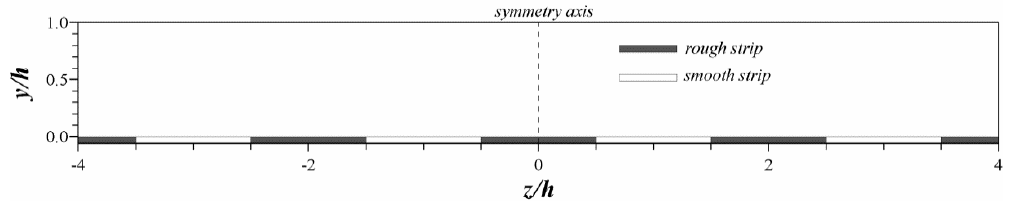
Figure 2. Cross-sectional view of the setup of the large-eddy simulations